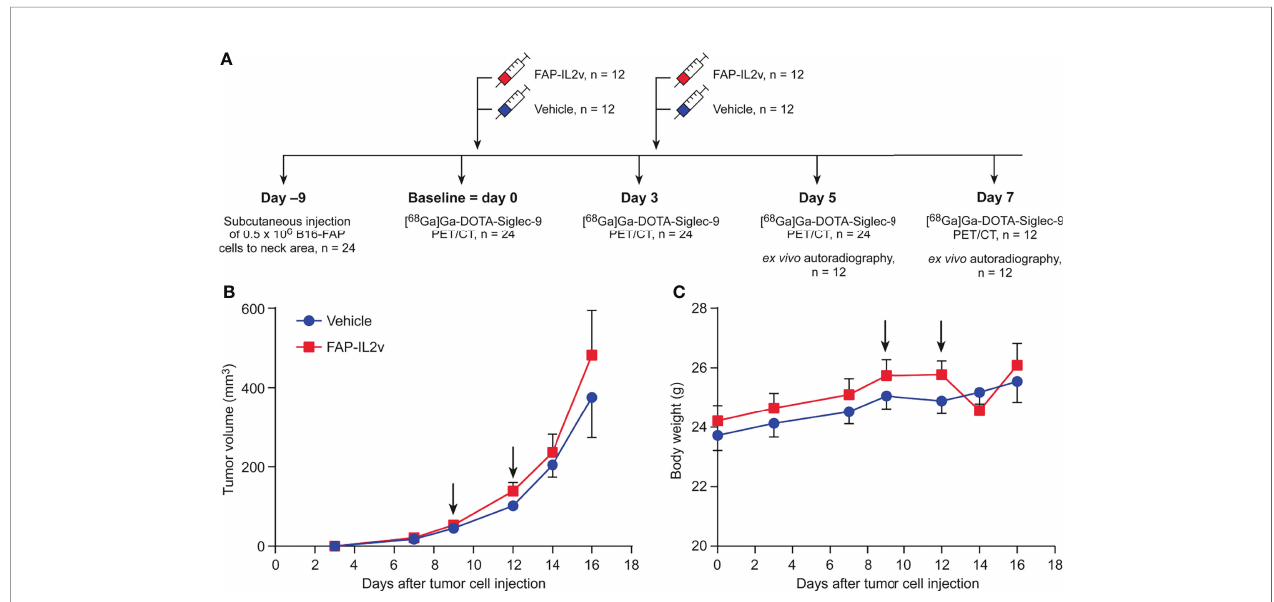
FIGURE 1 | Tumor growth and body weight are not altered after treatment with an IL-2 variant fused to fi broblast activation protein (FAP-IL2v). (A) Experimental study design. (B) Growth curves of B16-FAP melanoma tumors treated with FAP-IL2v or vehicle during the follow-up period ( n = 6-12/group). Baseline PET/CT imaging was performed on day 9. (C) Body weight of FAP-IL2v-treated and vehicle-treated group during the follow-up period ( n = 6-12/group). The black arrows indicate the administrations of the drug or